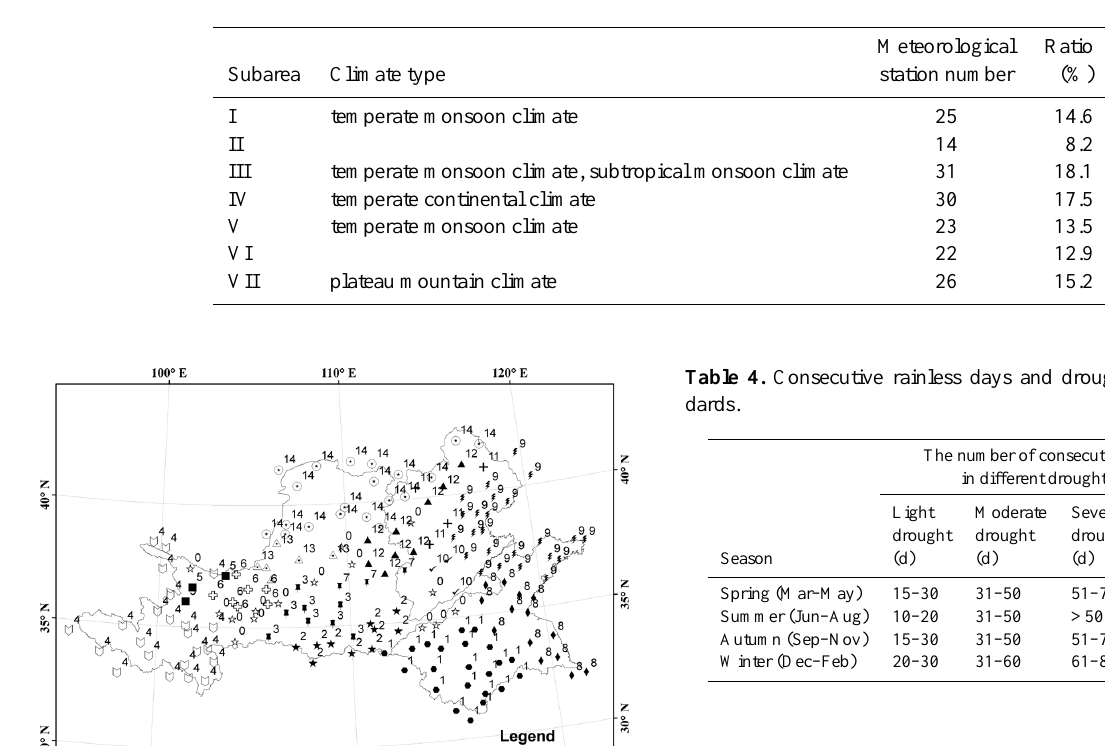
Table 3. Basic information of basin subareas.